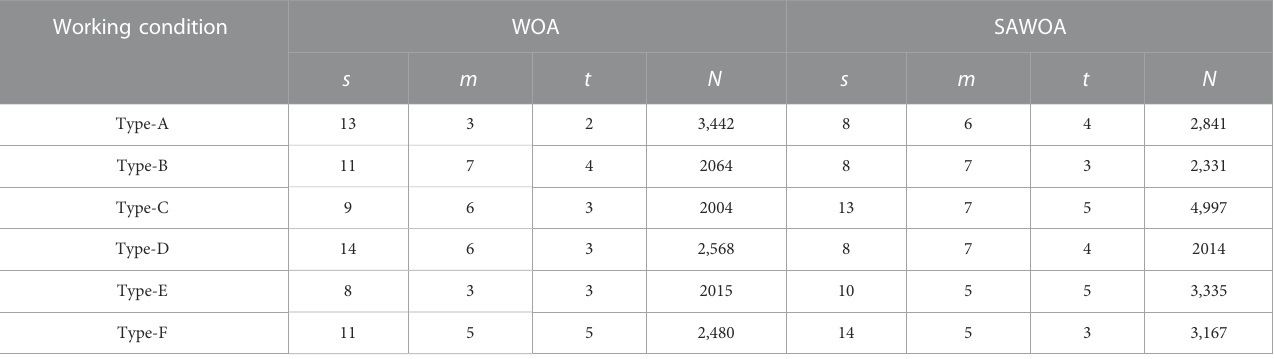
TABLE 4 Optimized parameters of MPE. Working condition WOA